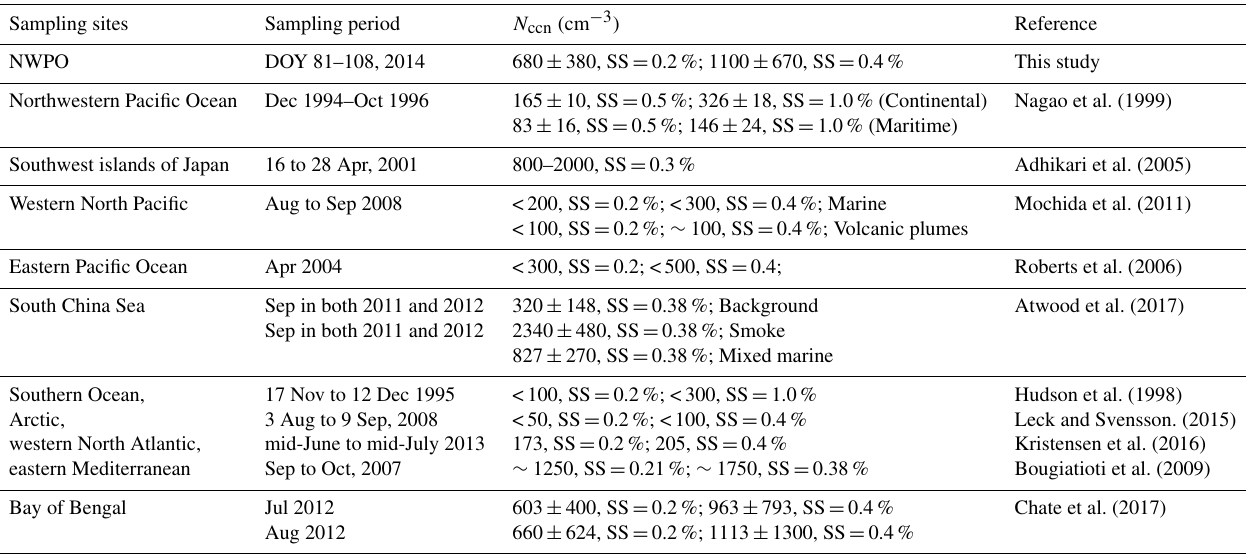
Table 2. Concentrations of CCN reported from different marine